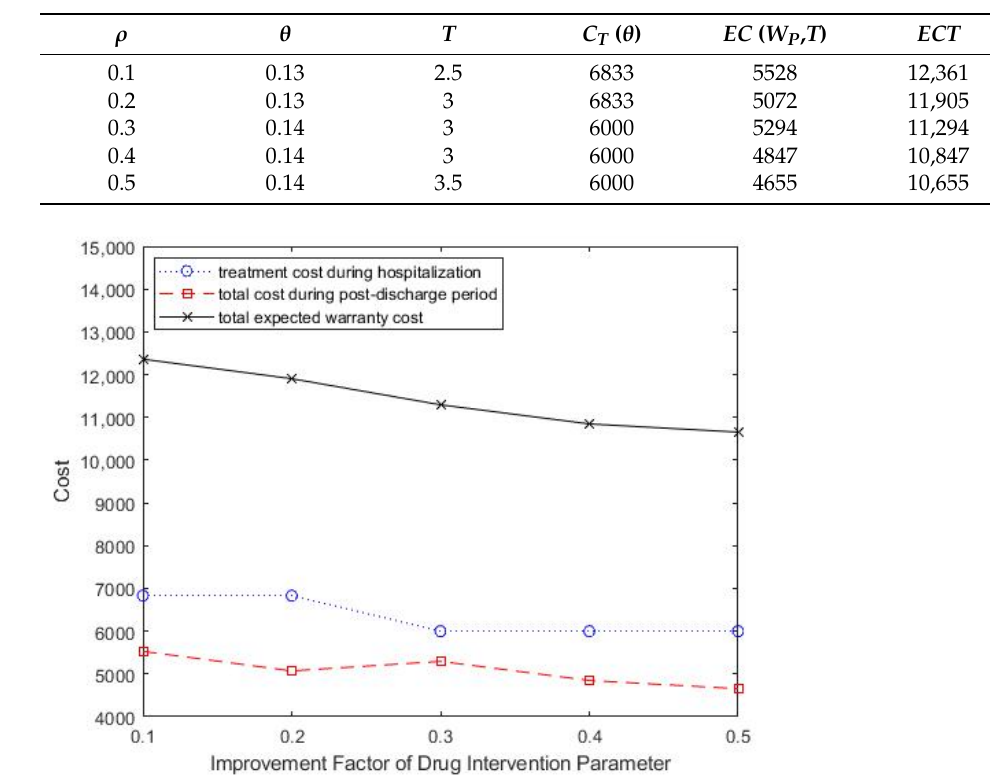
Figure 7. Change in improvement factor parameter of drug intervention, ρ , for total